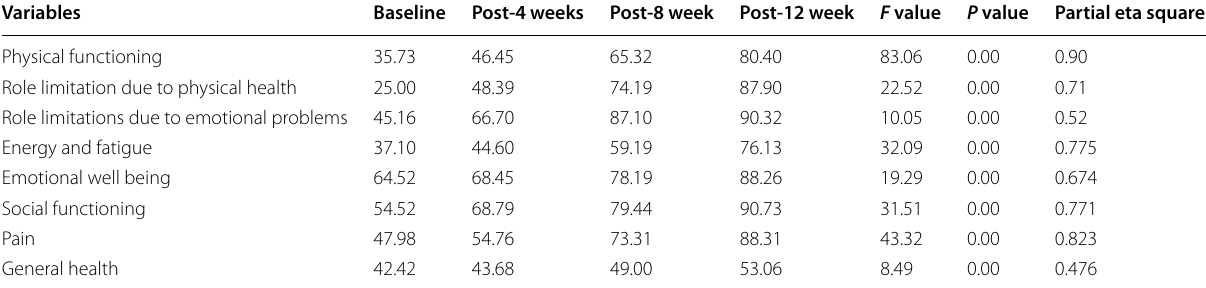
Table 4 Change in domains of quality of life pre- to post-intervention